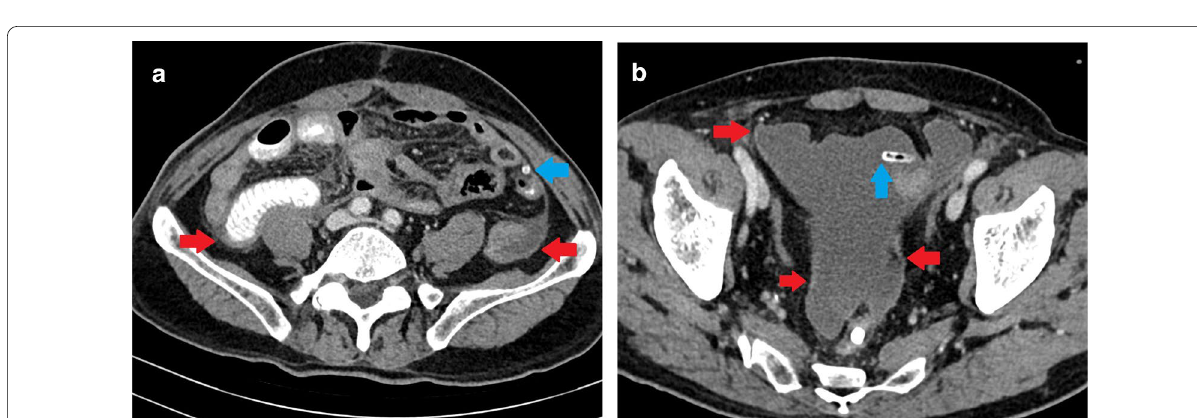
Fig. 7 Premature closure bias causing an under-reading (type 4) error. A 52-year-old male patient with metastatic gastric cancer was brought to the emergency room due to abdominal pain, distension and discomfort. Abdominal CT showed thickened and enhanced peritoneal layers (red arrows a , b ) and accompanying pelvic-free fluid/mesenteric congestion. The radiologist prematurely jumped to the conclusion of “peritoneal carcinomatosis” because of the cancer history and did not think about other reasons that could cause those imaging findings. In the following period, it was retrospectively understood that there was a displaced jejunostomy catheter (blue arrows a , b ) into the peritoneal space. Due to premature closure bias, the radiologist did not pay enough attention to the rest of the examination and overlooked the displaced catheter. The patient was hospitalized and given long-term treatment. After removing the misplaced catheter and completing the appropriate treatment of peritonitis, induced by nutrients given through the jejunostomy, the patient’s complaints completely